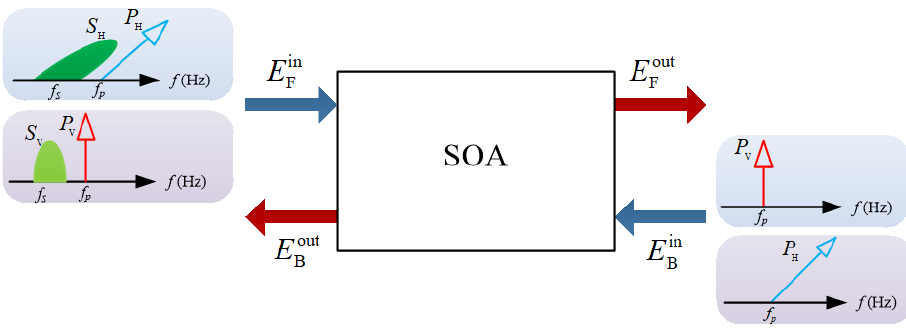
Figure 1. Schematic diagram of the OPC process based on a nonlinear bidirectional SOA.